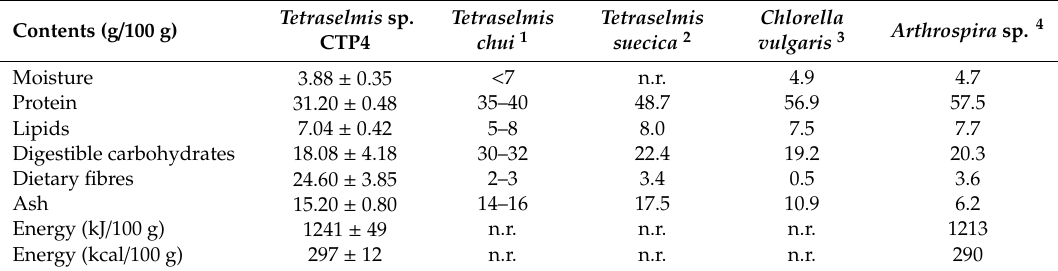
Table 1. Proximate composition of Tetraselmis sp. CTP4 grown semi-continuously in industrial tubular photobioreactors (g / 100 g). Values represent the mean and corresponding standard deviation ( n = 3). Values from the literature for Tetraselmis chui , Tetraselmis suecica , Chlorella vulgaris and Arthrospira sp. are also presented. n.r.—not